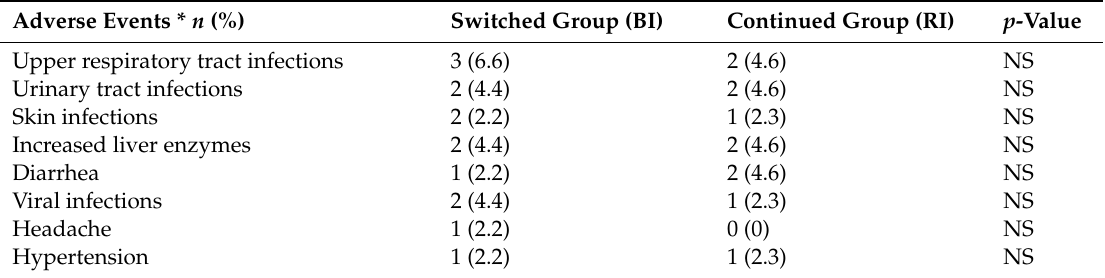
Table 3. Adverse events during follow-up in AS patients switched to BI versus those continuing